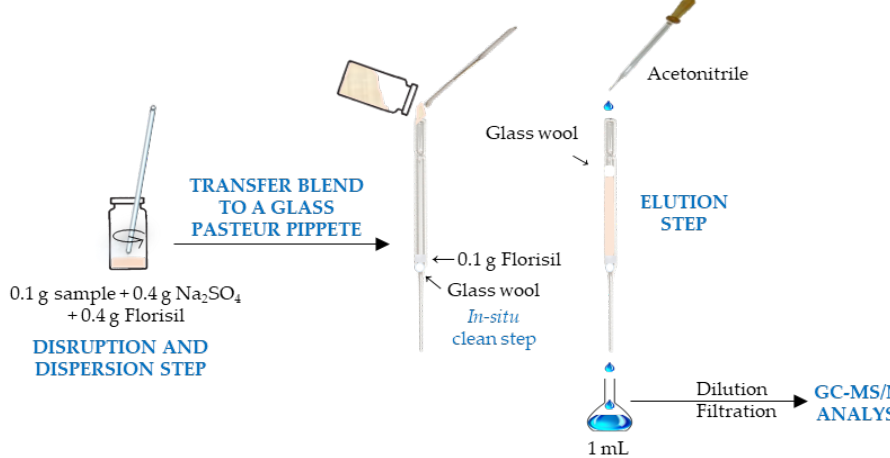
Figure 1. Schematic representation of the micro-matrix solid-phase dispersion (µ-MSPD) procedure under the optimal conditions .